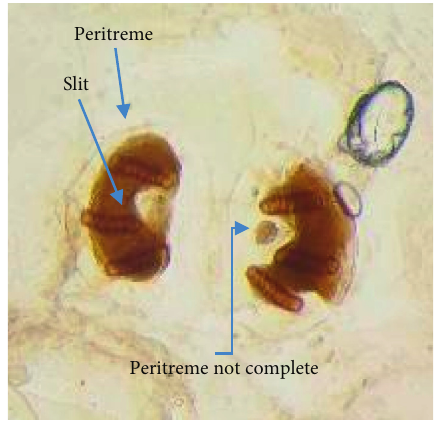
Figure 3: Posterior spiracles (after